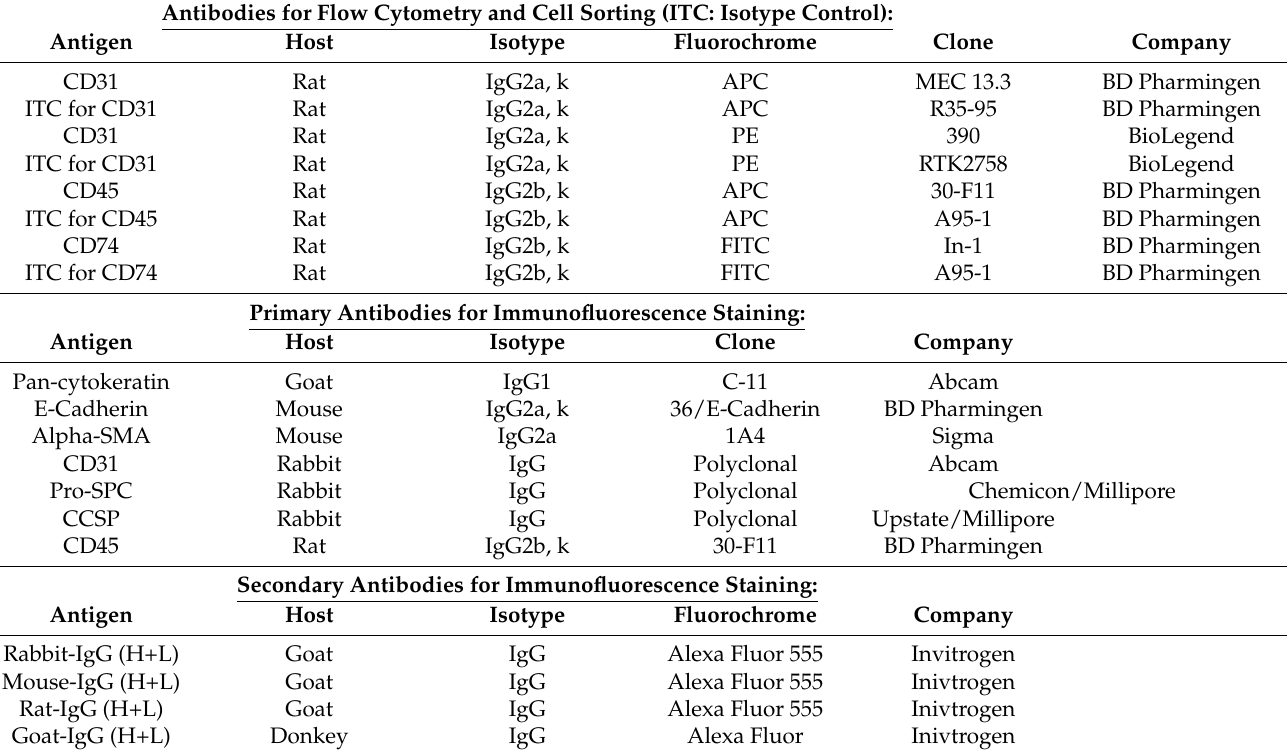
Table 1. Antibodies used in this